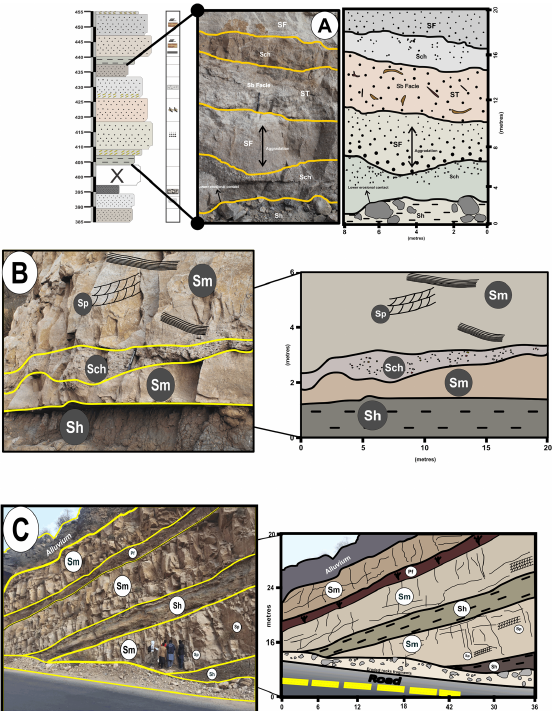
Figure 7. ( A ) Field sketch of fined-sandstone element (SF), filled with facies Sb, Sch, and Sh in the study area. The element SF is found in the lower and middle part of the Pab Formation, in the middle portion the aggradation is found in the Sf element; ( B ) photomosaic of channel deposit element (CH) interbedded with coarse-grained sandstone with Sm and Sp; and ( C ) fi eld sketch of laminated shale element (LS) in the middle part of the Formation. This element presents in b/w the Sm facies all over the Pab Formation and fi lled with facies Sp, Pf, Sm, and Sh in Pab Formation.